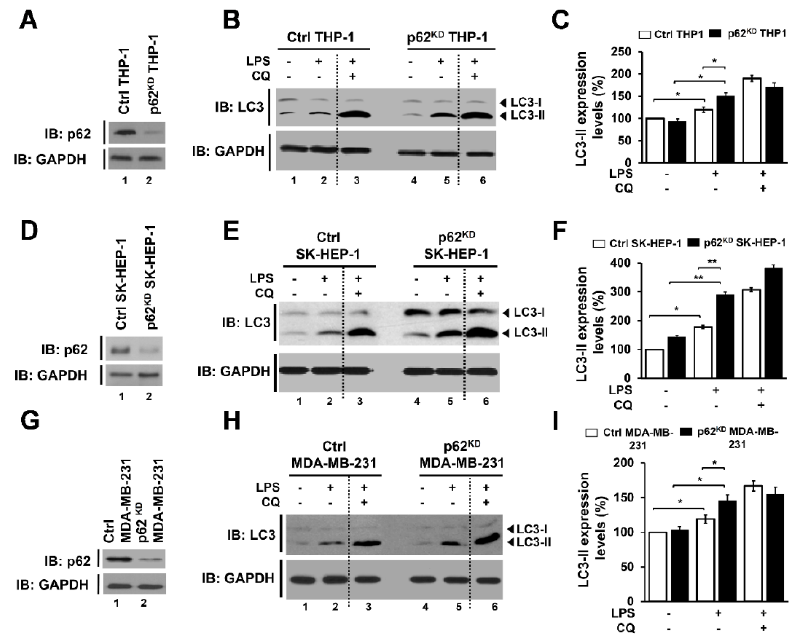
Figure 3. p62-deficient cells, p62 KD THP-1, p62 KD SK-HEP-1, and p62 KD MDA-MB-231 cells, exhibit enhanced autophagy activation in response to TLR4 stimulation. ( A ) p62 KD THP-1 cells were generated, and the knockdown e ffi cacy of p62 was confirmed with anti-p62 antibody. ( B , C ) Ctrl and p62 KD THP-1 cells were treated with or without vehicle or CQ (10 µ M), in the presence or absence of LPS (10 µ g / mL), for 6 h. Whole cell lysates were immunoblotted with anti-LC3A / B antibody and anti-GAPDH antibody as a loading control ( B ). The LC3II levels were analyzed with Image J program ( C ). Data shown are averages from a minimum of 3 independent experiments ( ± SEM). *, p < 0.05. ( D ) p62 KD SK-HEP-1 cells were generated, and the knockdown e ffi cacy of p62 was confirmed with anti-p62 antibody. ( E , F ) Ctrl and p62 KD SK-HEP-1 were treated with or without vehicle or CQ, in the presence or absence of LPS. Whole cell lysates were immunoblotted with anti-LC3A / B and anti-GAPDH antibodies ( E ). The LC3II levels were analyzed with Image J program ( F ). Data shown are averages from a minimum of 3 independent experiments ( ± SEM). *, p < 0.05 and **, p < 0.01. ( G ) p62 KD MDA-MB-231 cells were generated, and the knockdown e ffi cacy of p62 was confirmed with anti-p62 antibody. ( H , I ) Ctrl and p62 KD MDA-MB-231 were treated with or without vehicle or CQ, in the presence or absence of LPS. Whole cell lysates were immunoblotted with anti-LC3A / B and anti-GAPDH antibodies ( H ). The LC3II levels were analyzed with Image J program ( I ). Data shown are averages from a minimum of 3 independent experiments ( ± SEM). * p <